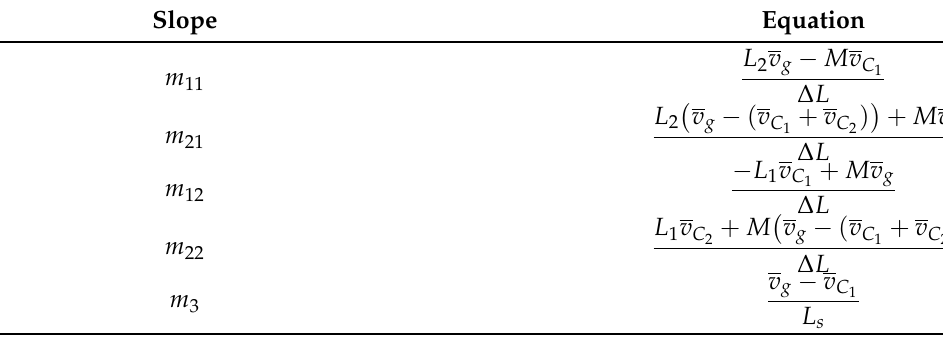
Table 1. Dynamic model slopes for the SEPIC converter.